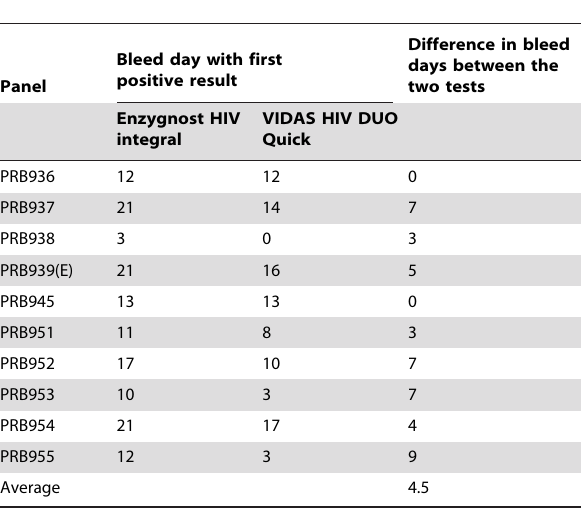
Table 1. Test performance to detect bleed day with first positive result using seroconversion panel